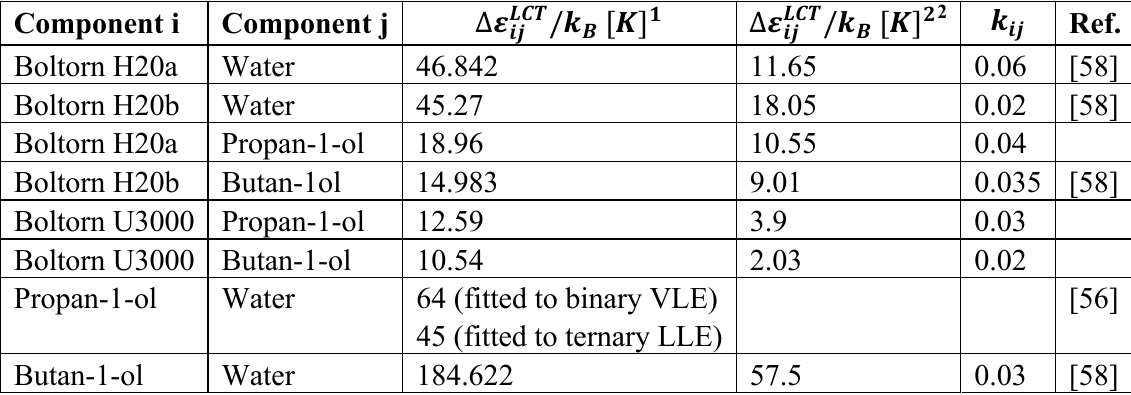
Table 6. Parameters of the